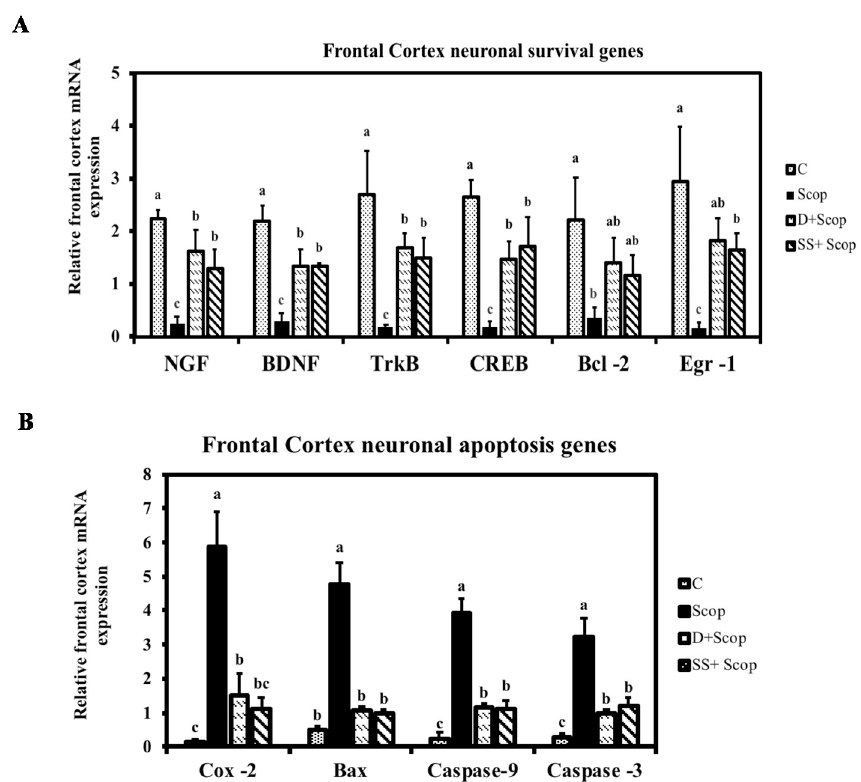
Figure 7. Effect of Stachys sieboldii in the mRNA expression of frontal cortical neuronal survival genes ( A ) and neuronal apoptosis genes ( B ) All values are mean ± SD ( n = 4). Mean with different superscripts in the same row such as a, b indicates significant difference by ANOVA with Tukey’s test at p < 0.05 compared to control group.